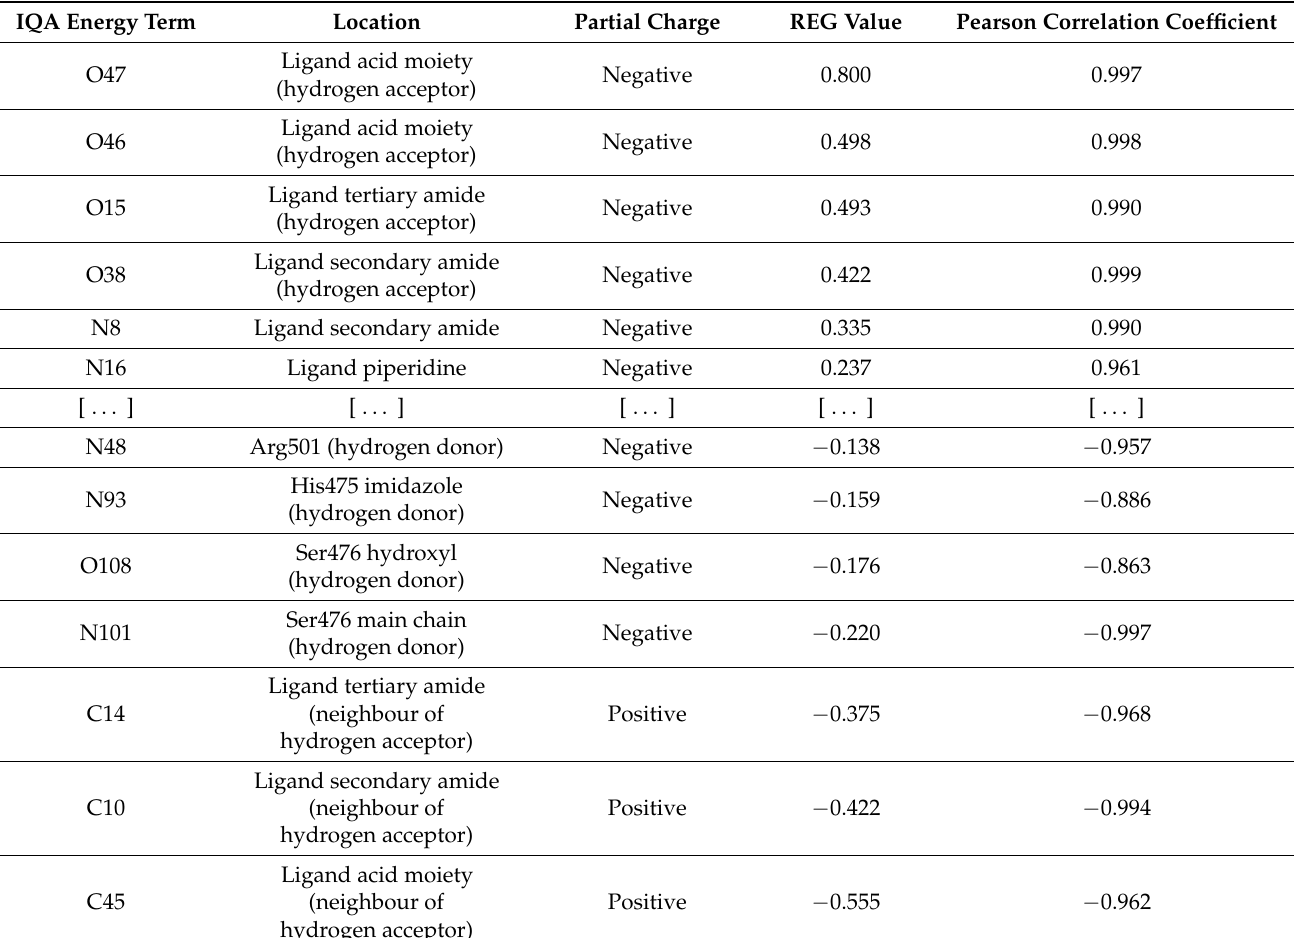
Table 4. Top and bottom full atomic contributions ( A-A (cid:48) ranking) for segment 2 in